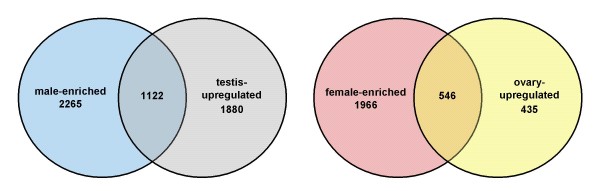
Overlap of sex- and gonad-biased gene expression. Male (left) and female (right) Venn diagrams, demonstrating the proportion of genes that fall into both sex- and gonad-biased expression categories. These numbers are based on a "strict consensus" FDR = 0.05, and no fold change threshold. Roughly 33% of male-enriched genes are also significantly testis-upregulated, whereas approximately 22% of female-enriched genes are also significantly ovary-upregulated.